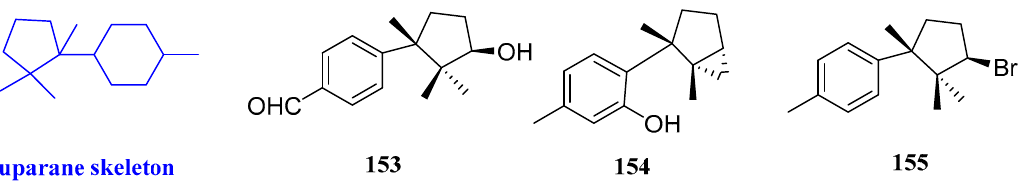
Figure 15. Structures of aromadendrane-type sesquiterpenoid 150 − 152 .